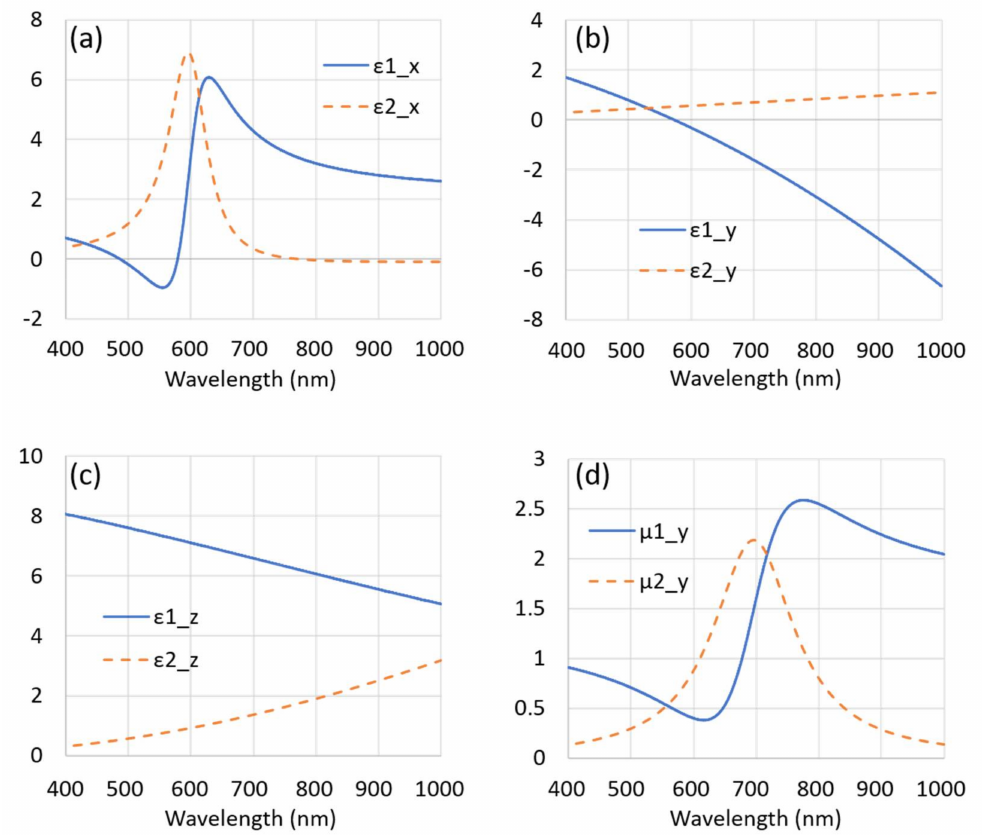
Figure 11. Retrieved parameters of the permittivity and permeability via our methods; note µ x and µ z (not pictured) are unity. ( a – c ) respectively show the x-, y-, and z-components of the permittivity while ( d ) shows the y-component of the permeability. ε 1 and µ 1 refer to real parts, while ε 2 and µ 2 refer to imaginary parts of the corresponding